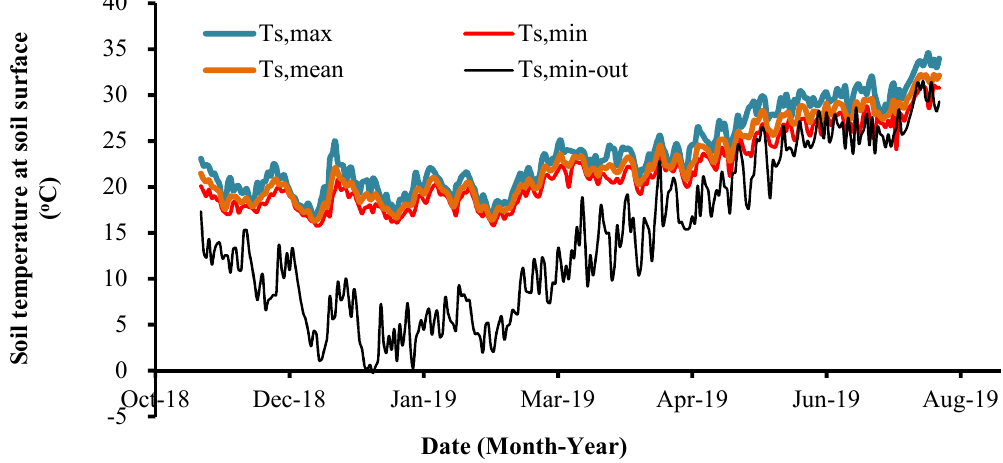
Figure 9. Daily maximum (Ts,max), minimum (Ts,min), and mean (Ts,mean) soil surface temperature inside the sunken solar greenhouse, and the estimated daily minimum outside soil surface temperature (Ts,min-out) from October of 2018 to July of 2019.